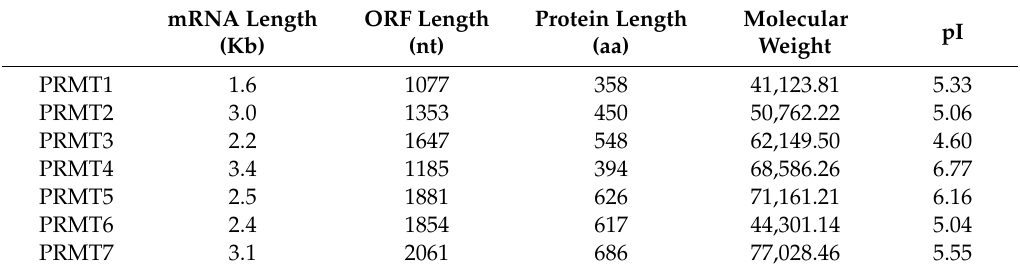
Table 3. The P. lividus